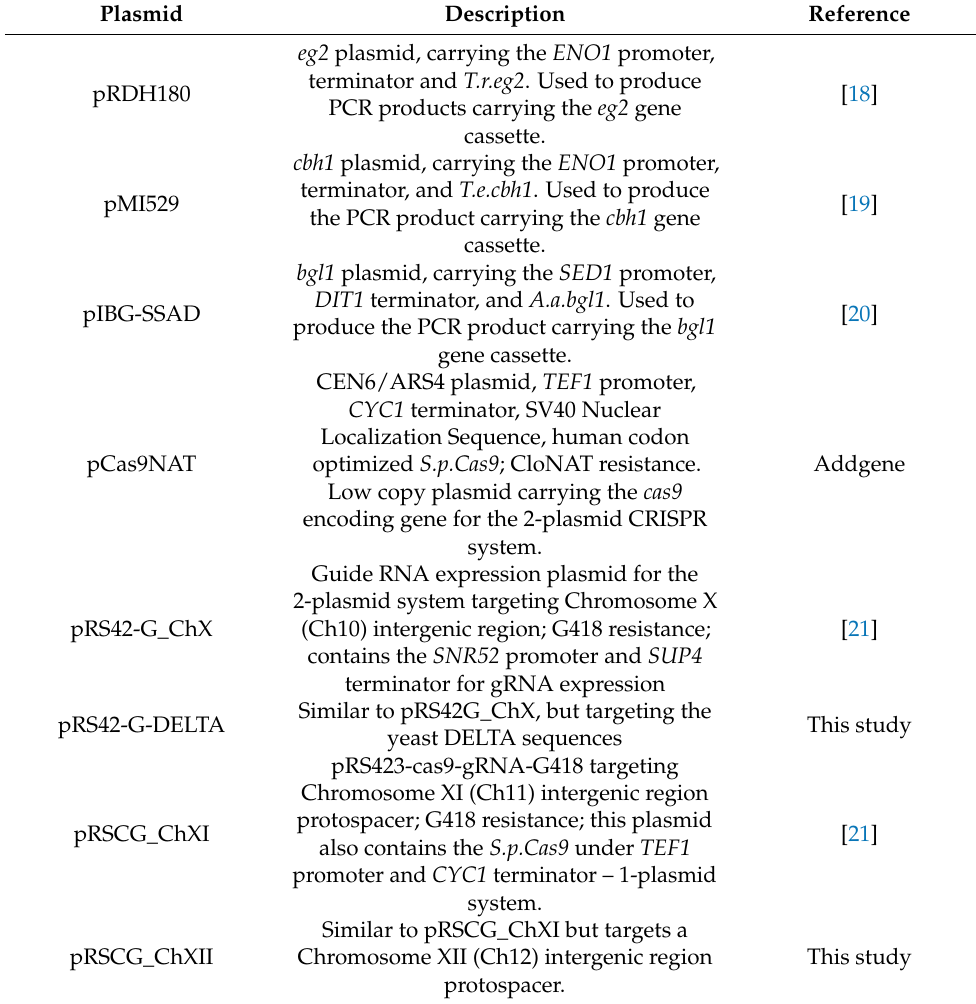
Table 1. Plasmids used in this